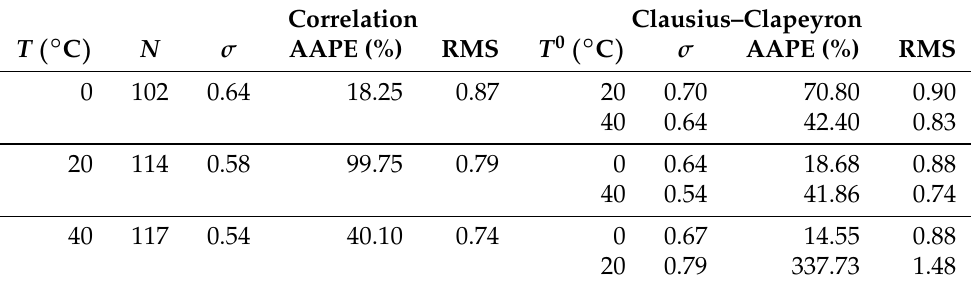
Table 3. Summary of the goodness of fit of using the correlation (Equation (17)) for ln P sat at the temperature of interest as compared to the Clausius–Clapeyron equation (Equation (21)) with the indicated reference temperature. The goodness of fit is quantified using the standard deviation ( σ ), the average absolute percent error (AAPE), and the root-mean-squared error (RMS), where N corresponds to the number of organic compounds for which reference value of ln P sat are available at the temperature of interest. The goodness of fit is computed for ln P sat , where P sat is in units of bar.